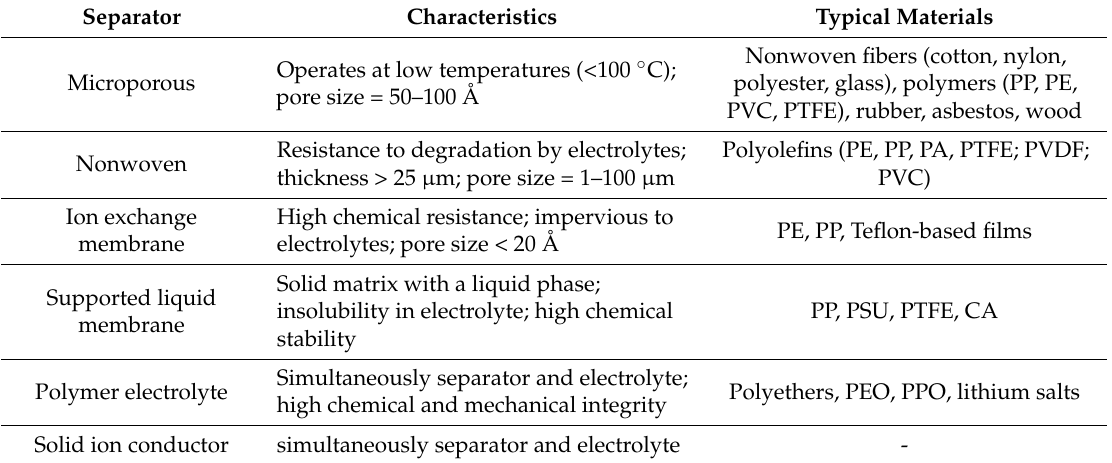
Table 1. Types and characteristics of different separators adapted from [10].